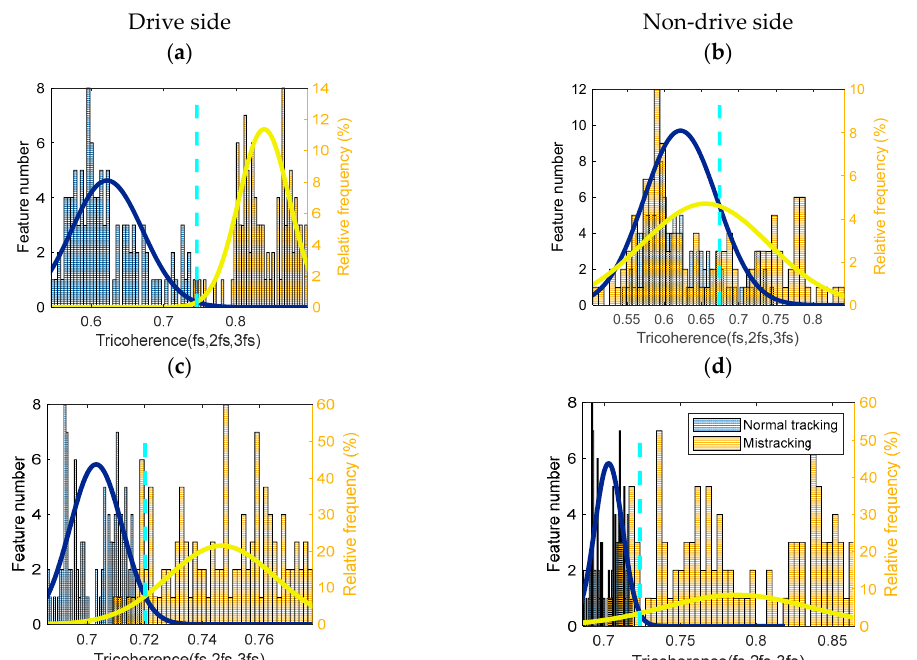
Figure 6. Histogram, normal power density function and diagnostic threshold represented as the aqua dotted line of the tricoherence (fs, 2fs, 3fs) for normal and mis-tracking conditions: ( a ) Drive side belt mis-tracking under no-load condition, ( b ) Non-drive side belt mis-tracking under no-load condition, ( c ) Drive side belt mis-tracking under 20 kg load condition, ( d ) Non-drive side belt mis-tracking under 20 kg load